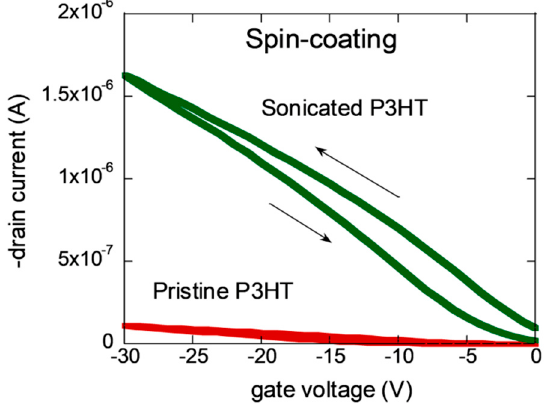
Figure 2. Comparison of the I D -V G transfer characteristic plots of the P3HT films prepared by spin-coating. The applied drain voltages were − 8 V. For the pristine and sonicated P3HT films spin-coated from the P3HT solution (10 mg / mL, chloroform), the FET hole mobilities were 2.2 × 10 − 4 and 3.2 × 10 − 3 cm 2 / Vs, respectively. The FET hole mobilities were extracted from the forward gate scan, which is scanned from the positive to the negative gate voltage.